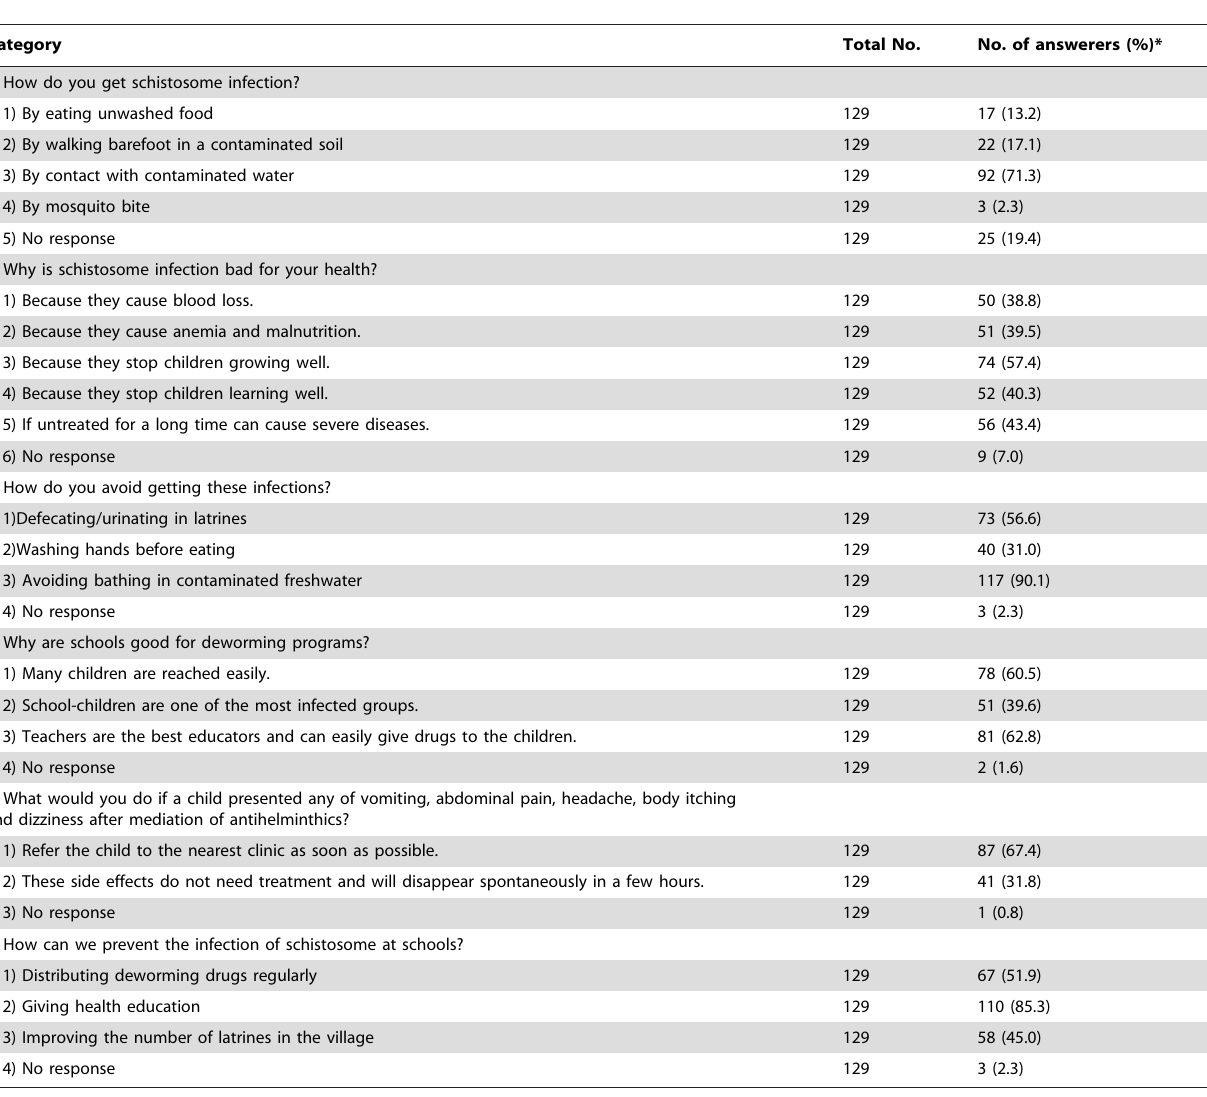
Table 7. The results of questionnaires about schistosomiasis from school teachers before health education.